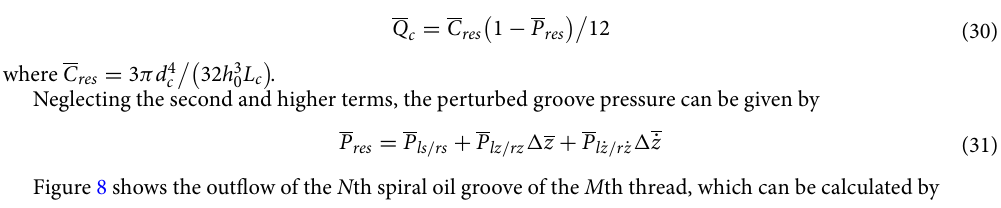
Flow continuity equation. The dimensionless form of flow through the capillary restrictor is derived as